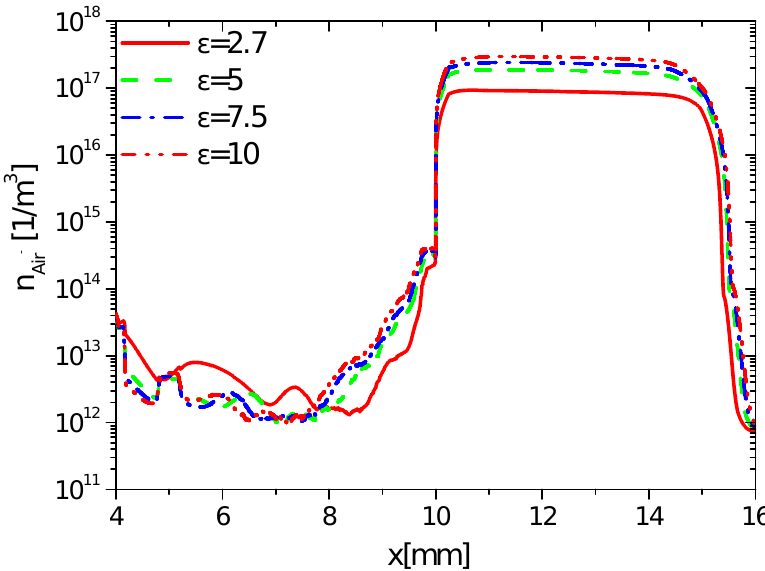
Figure 13. Effect of ε on the distributions of n Air − at 35 ns in the fall